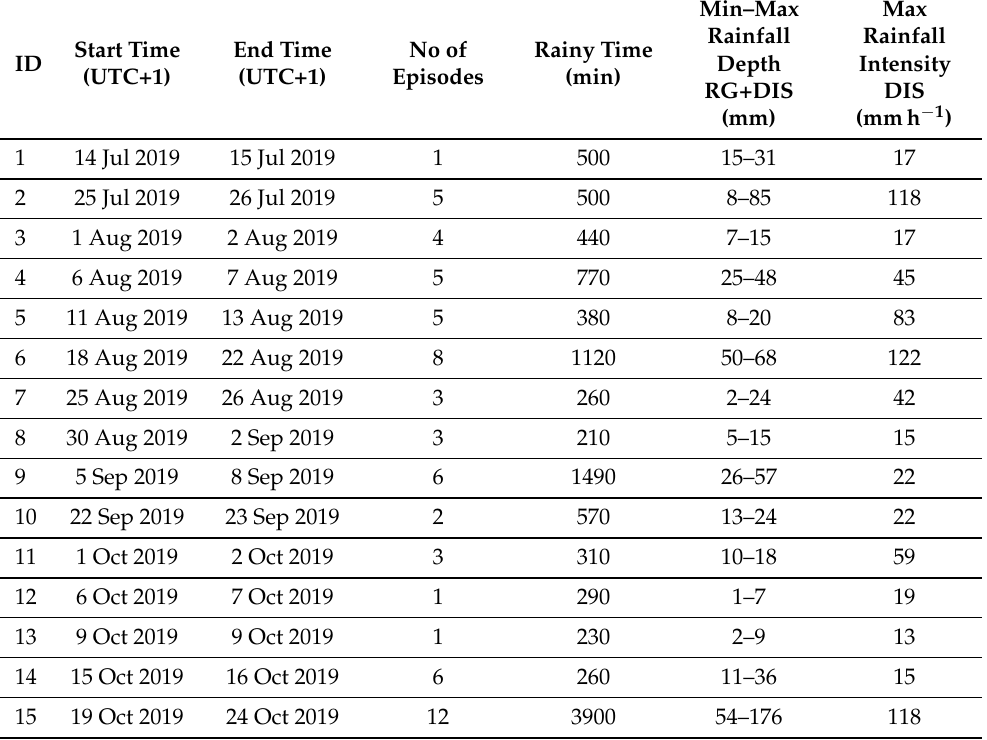
Table 3. Database with the information of the 15 analyzed